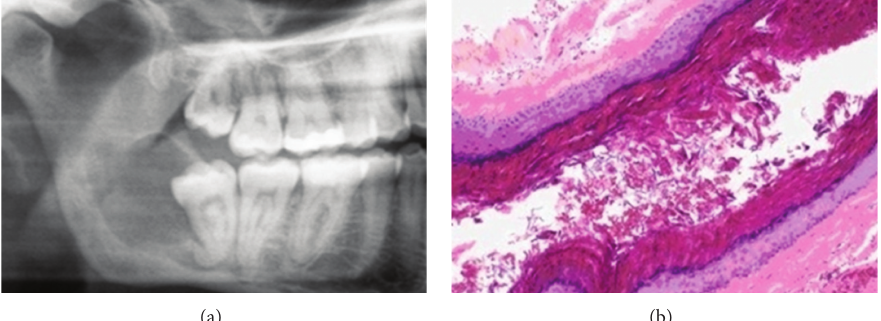
Figure 2: (a) Unilocular radiolucent lesion distal to 4.8. (b) Fibrous connective tissue with a stratified epithelium with orthokeratosis lining.